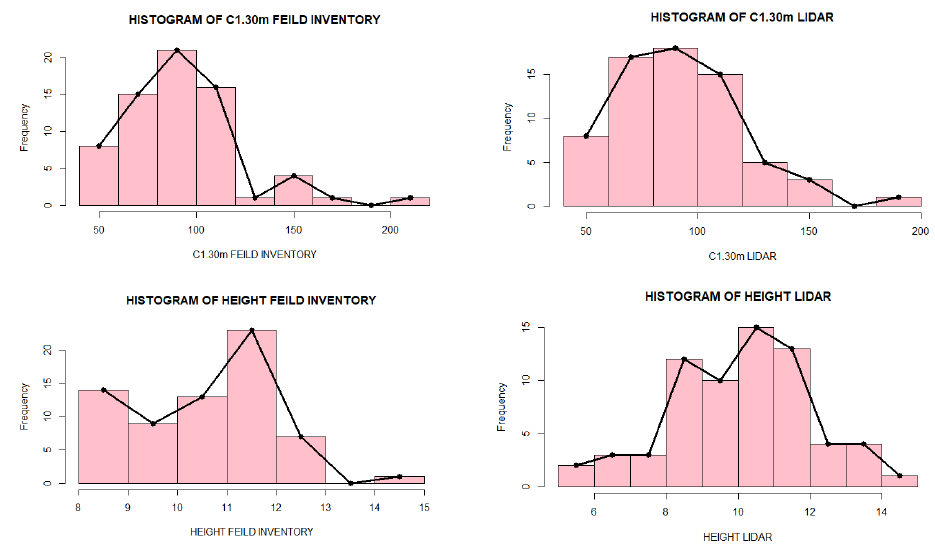
Figure 8. Histograms distribution of tree height (m) and circumference at 1.30 m (cm) measured by field data collection and those extracted from UAV-ALS and TLS data (Lidar) . The p -values from the Shapiro – Wilk test (Table 4) confirm that the circumference at 1.30 m, the tree height measured by the field data collection, and the circumference at 1.30 m extracted by ALS-UAV-TLS data do not follow a normal distribution, except for the tree height extracted from ALS-UAV-TLS data. To compare the means of the two methods, a non-parametric test was used (Wilcoxon-test). The p -values of this test (Table 4) showed that the means of the circumference at 1.30 m and tree height derived from the two methods are not significantly different (since we rejected the null hypothesis of normality for both distributions at the 5% significance level). Table 4. Shapiro – Wilk test of dendrometric parameters (H, C1.30m), biomass, and carbon stock (aboveground, belowground, and total) measured and estimated with field data collection and from UAV-ALS-TLS data. Wilcoxon test between dendrometric parameters (H, C1.30m), biomass, and carbon stock (aboveground, belowground, and total) measured and estimated with field data collection and from UAV-ALS-TLS data. Shapiro-Test W p -Value C1.30m (cm)